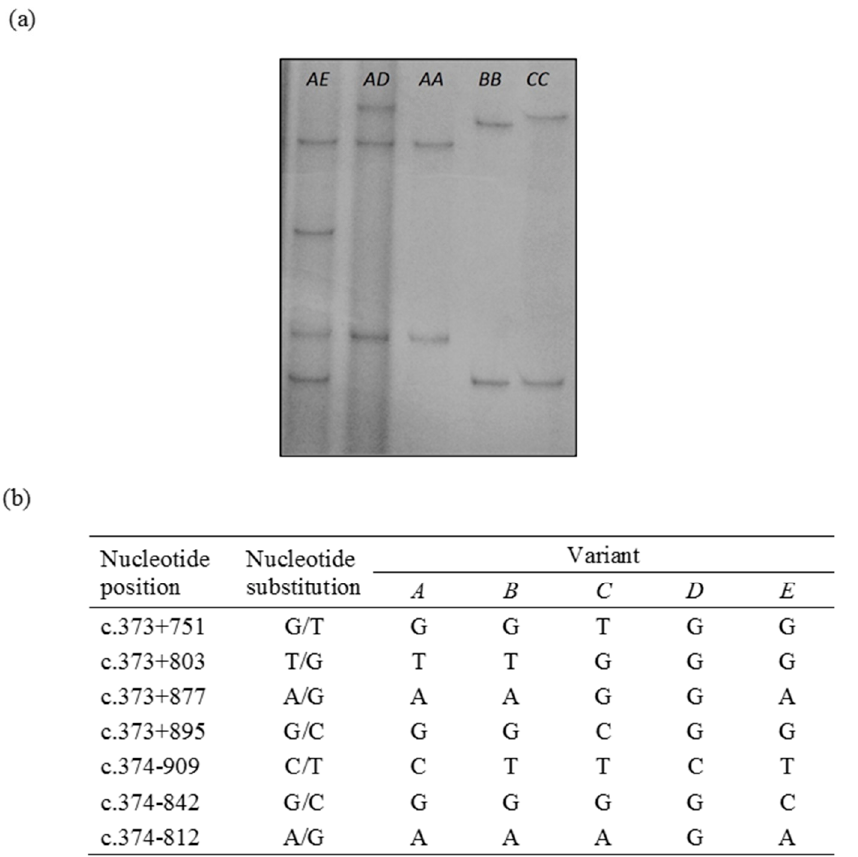
Figure 1. Variation in intron 1 of bovine MSTN revealed using PCR-SSCP analysis ( a ) and verified with nucleotide sequencing ( b ). Five PCR-SSCP patterns, representing the five distinct sequence variants ( A–E , in both homozygous and heterozygous genotypes) are shown. Table 1. Associations between milk fatty acid methyl ester levels and myostatin genotypes in NZ HF × J cross cows ( n =